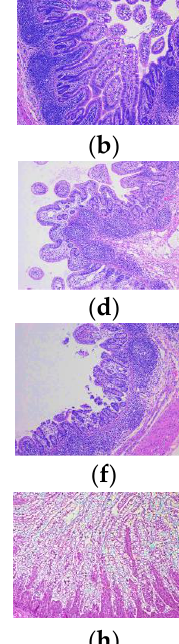
Figure 2. Hematoxylin and eosin-stained jejunal lesions in Gn pigs following oral inoculation with Arg P[6] HRV. All tissues were collected at necropsy on PID 2 or 3. ( A ) Villous damage with fibrin thrombi. ( B ) Atrophy of the enterocytes. ( C ) Hemorrhage is present in the lamina propria. ( D ) Nor-